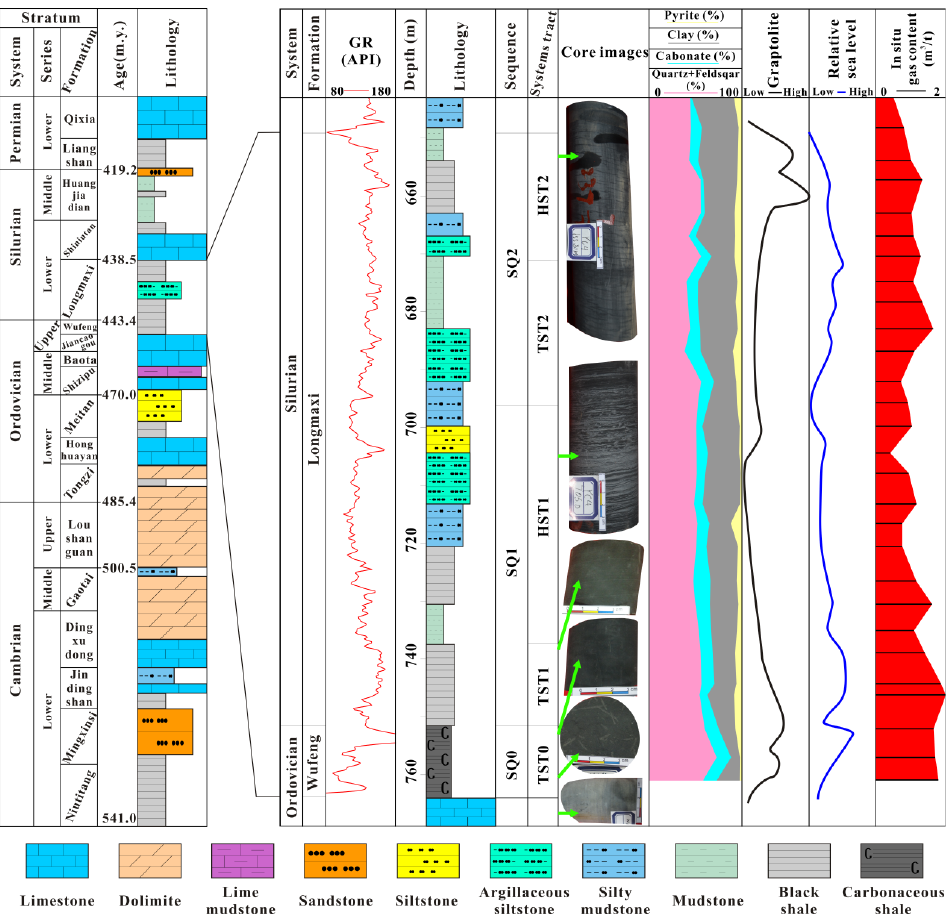
Figure 2. Sedimentary bottom framework of Wufeng – Longmaxi Formation in Sichuan Basin.